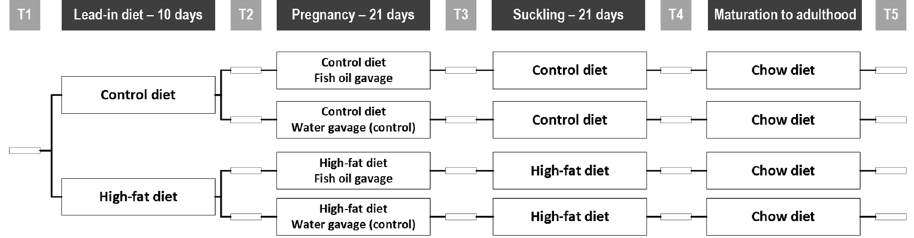
Figure 1. Diagram describing individual steps of the trial and indicating the timing of assessments. T1: Virgin female rats were randomised to control or high-fat diet. T2: Females were mated and further randomised to one of the two gavage treatments, i.e. Fish oil or Control (water). T3: on postnatal day 2 pups were counted, sexed and weighed; excess pups were culled. T4: on postnatal day 21 pups were separated, while dams were culled and